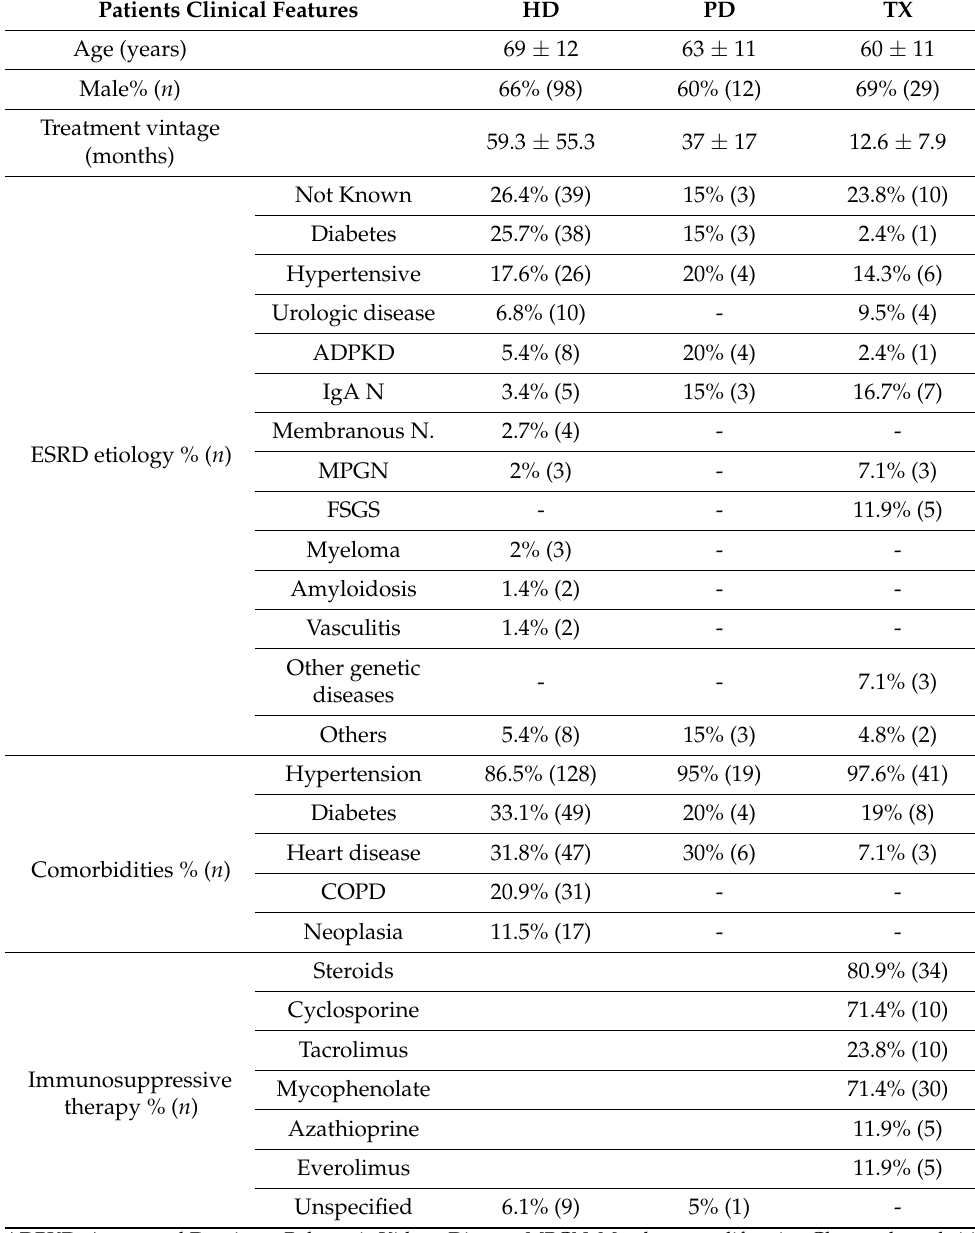
Table 1. Population